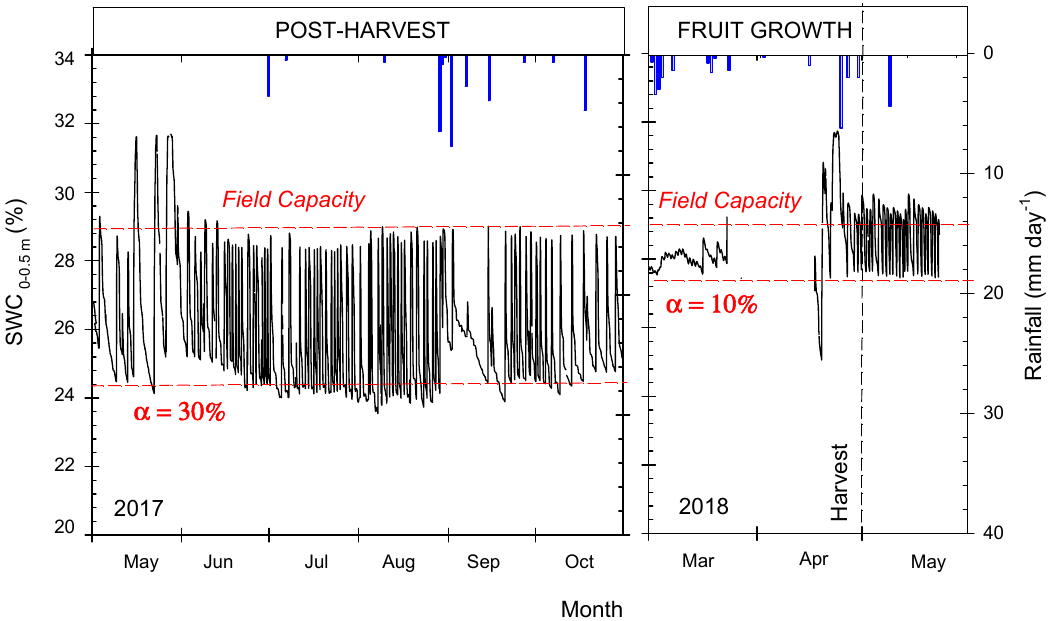
Figure 1. Soil water content (SWC, %) in the 0–0.5m soil profile during 2017 / 2018 growing season. Dashed horizontal lines delimit field capacity and the allowed water deficit threshold values ( α ): 30% (post-harvest 2017) and 10% (fruit growth 2018). Vertical bars indicate daily rainfall (mm).